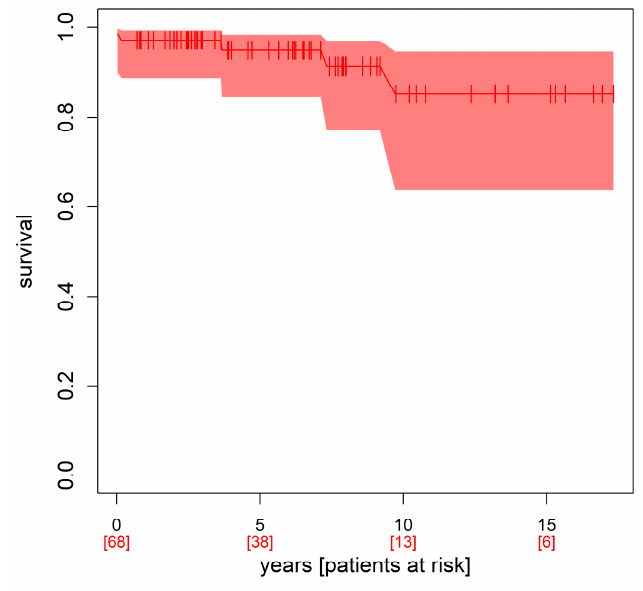
Figure 5. Kaplan–Meier survival curve. Table 5. Proportion of deceased patients and patients alive today and causes of death.